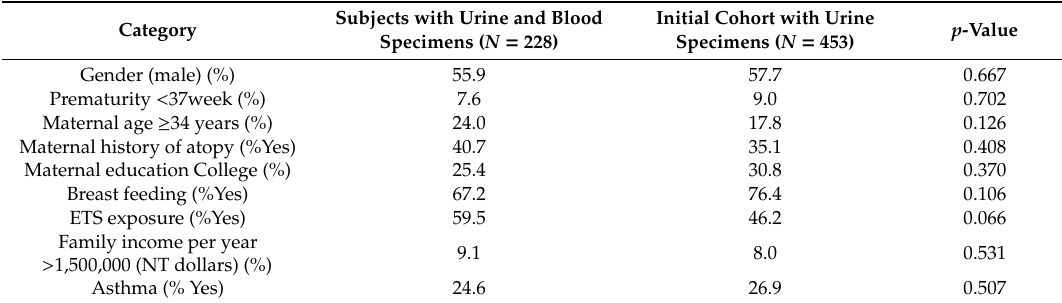
Table 1. Characteristics of the total population and the analyzed